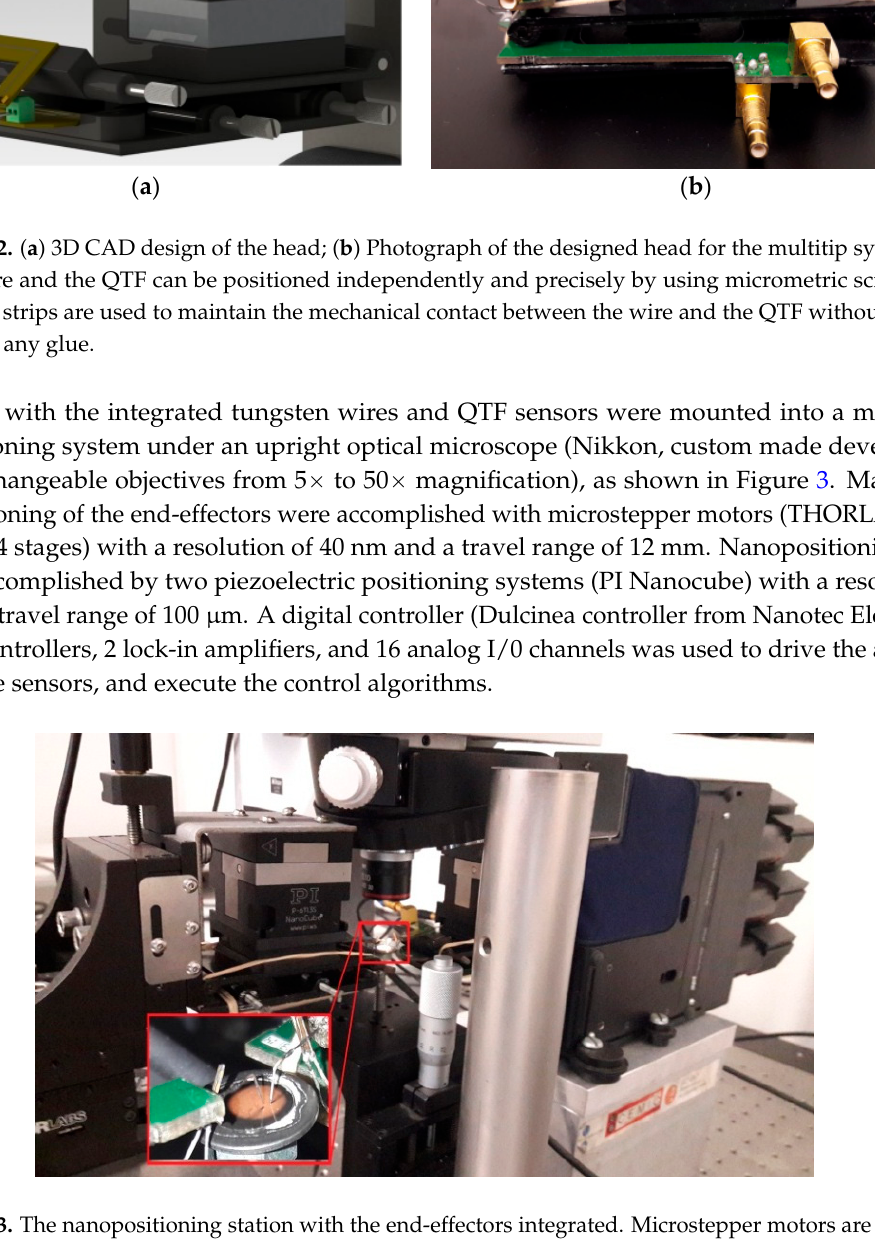
Figure 3. The nanopositioning station with the end-effectors integrated. Microstepper motors are used for coarse positioning and piezoelectric actuators for fine positioning. The sample and the end-effectors are visualized by an upright optical microscope.